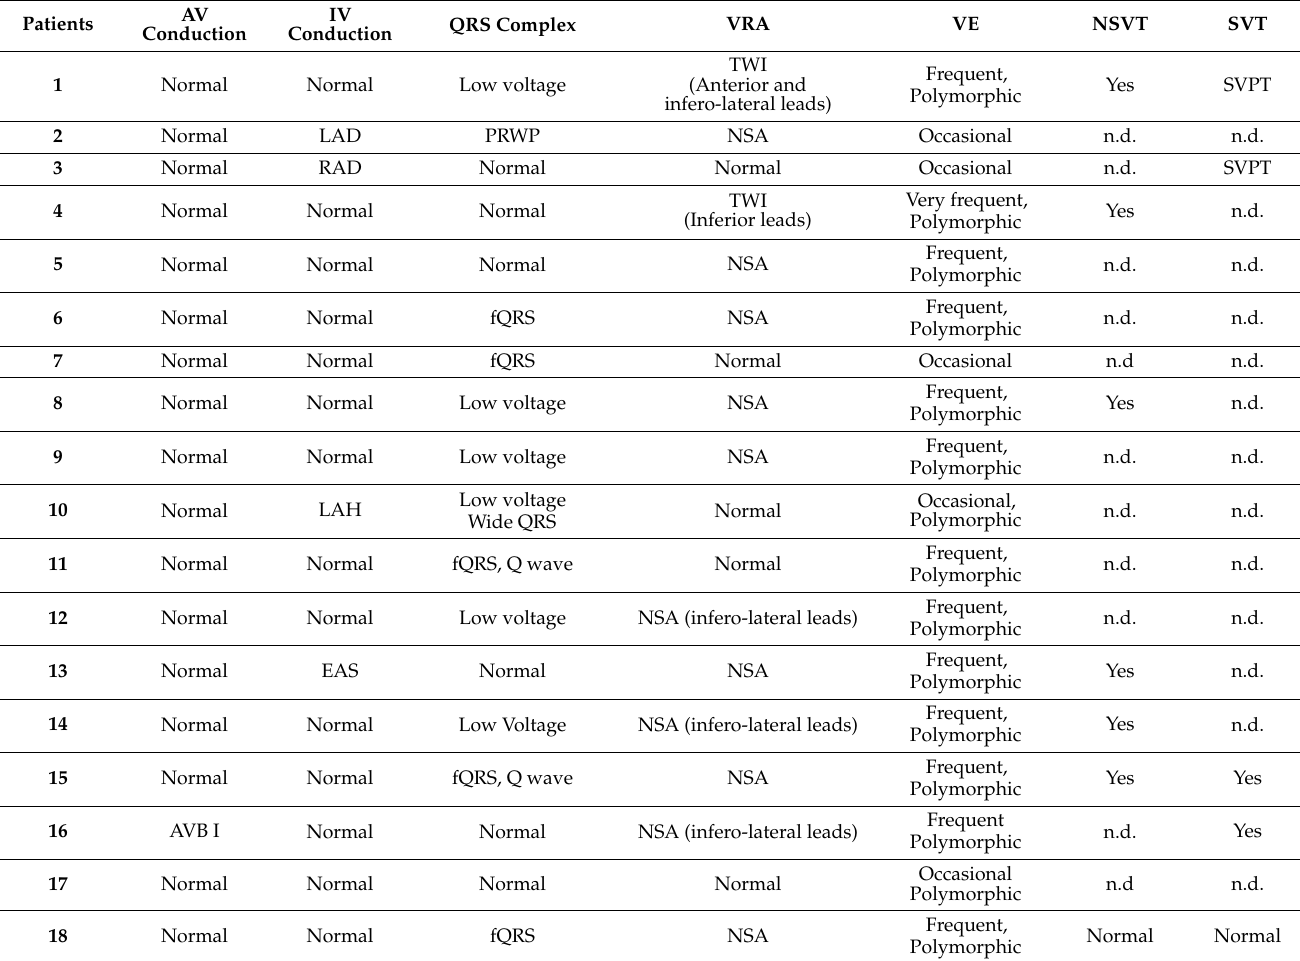
Table 4. Electrocardiographic findings and arrhythmia burden of our